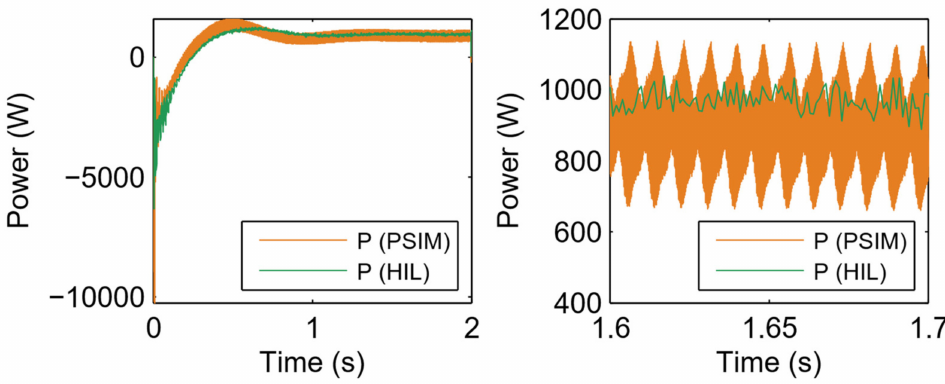
Figure 29. P response under closed loop and inverter mode conditions.